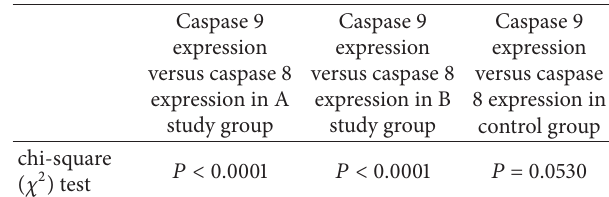
Table 1: The differences in caspase 9 and caspase 8 expression in